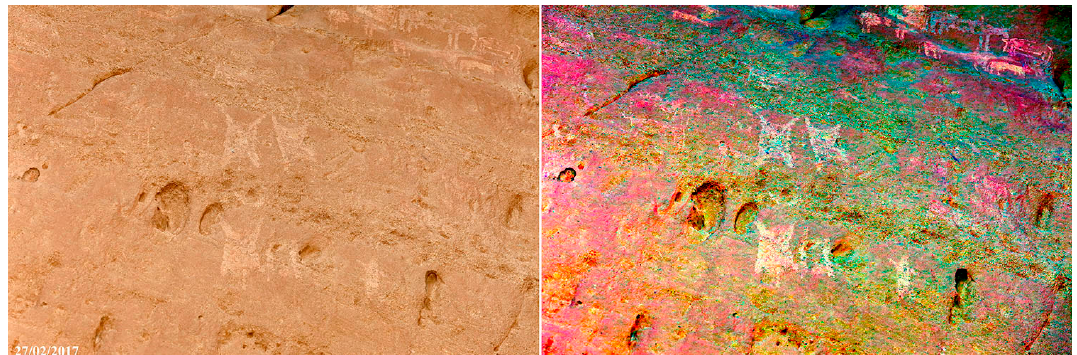
Figure 11. Square motifs with appendages painted in solid white at P6 (Photo: Alessandro Menardi